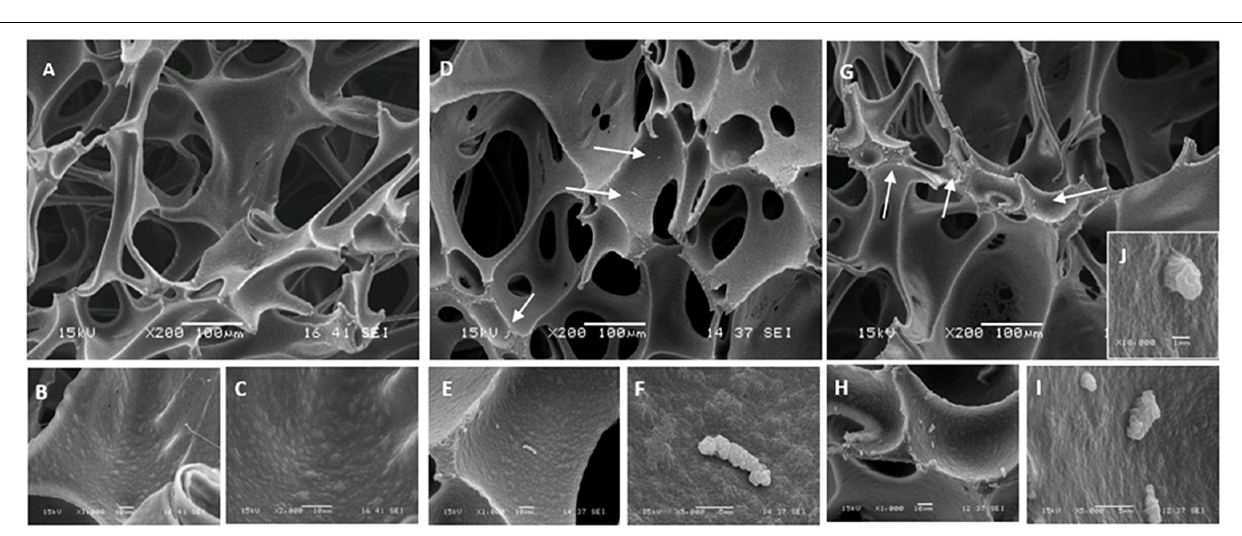
FIGURE 6 | Scanning electron micrographs of the polyurethane sponge with P. azotoformans PFl1A biofilm remaining after sampling. (A–C) Clean sponge observed at 200 × , 1,000 × , and 2,000 × magnification. (D–F) Images of the sponge at 200 × , 1,000 × , and 5,000 × magnification, after biofilm removing and 30 s of intense agitation with the Pulsifier to suspend sampled cells. (G–J) Images of specify the sonicating sponge at 200 × , 1,000 × , 5,000 × , and 10,000 × magnification, after biofilm removing and 30 s of intense agitation with the Pulsifier. White arrows show remnants of P. azotoformans PFl1A